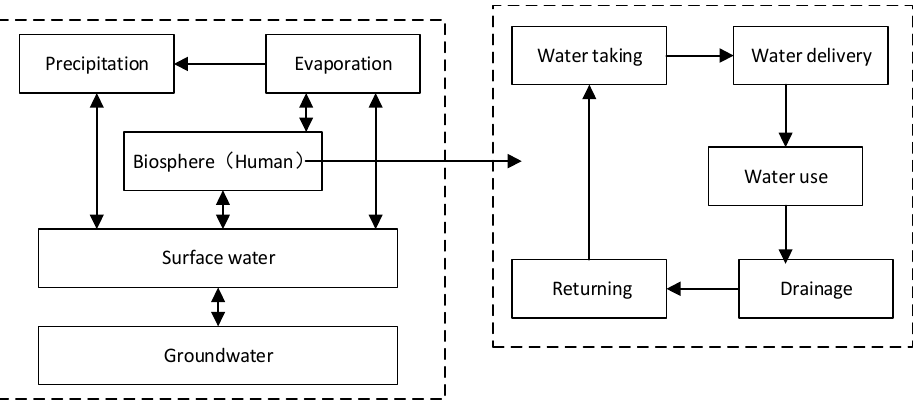
Figure 3. Relationship between the social water cycle and the natural water cycle.